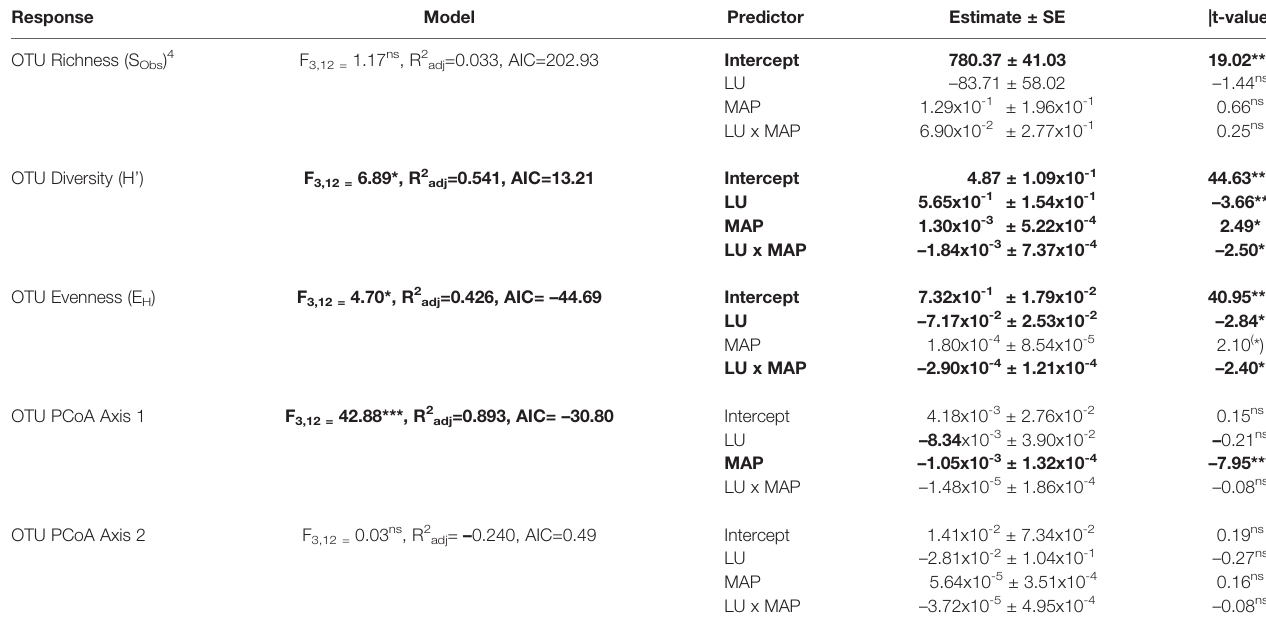
TABLE 3 | Multiple linear regression model statistics for fungal Operational Taxonomic Unit (OTU) community diversity, richness, evenness, and compositional estimates predicted by land use history (LU) and mean annual precipitation (MAP) normalized around the mean precipitation (730.01 mm yr -1 ) main effects and their interaction (LU x MAP) with native prairie remnants as reference (0) compared to post-agricultural sites